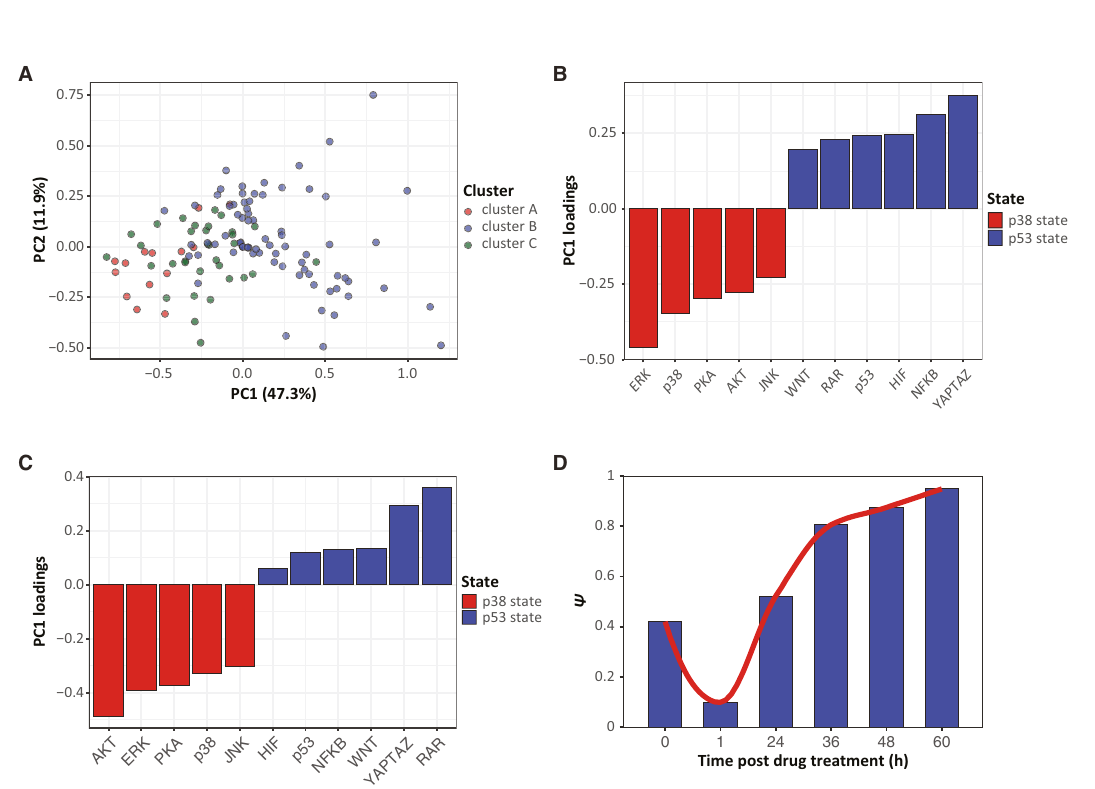
Fig. 4 Drug treatments increase the correlations between the activity of pathways. A Scatter plots of the activity scores of p38 and p53 reporters in the A375 signalome cell line before and at multiple time points after treatment with 122 active drugs. Each dot represents a different drug. Pearson ’ s r is depicted for each of the time points. B Pearson correlation coef fi cients were calculated for each pair of pathways in the A375 signalome cell line before and at different time points after treatment with 122 active drugs. Each datapoint represents a correlation value for one given pair of pathways over all 122 active drugs. The correlation between the activity score of p38 and p53 pathways is marked by a red circle. C – H Locally weighted smoothing (Lowess) regression of all reporters in each of the two signaling states is shown for six representative drug treatments, each associated with different drug targets. While three of the drugs drive the p53-signaling state ( C – E ), the other three drugs drive the p38 signaling state ( F – H ). The bold (red and blue) lines and the gray sleeves represent mean values and + / − SEM respectively. Source data are provided with this paper.